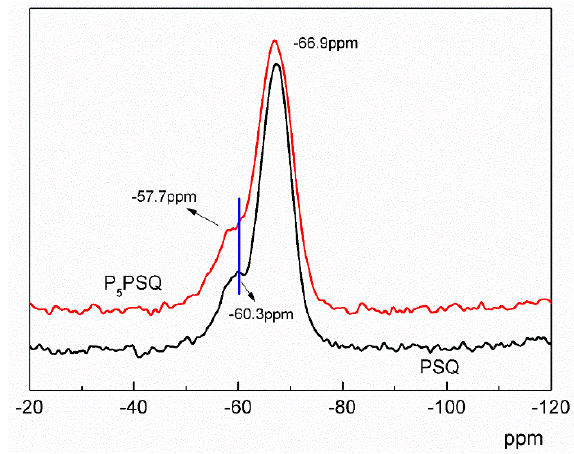
Figure 2. 29 SiNMR of PSQ and P 5 PSQ.